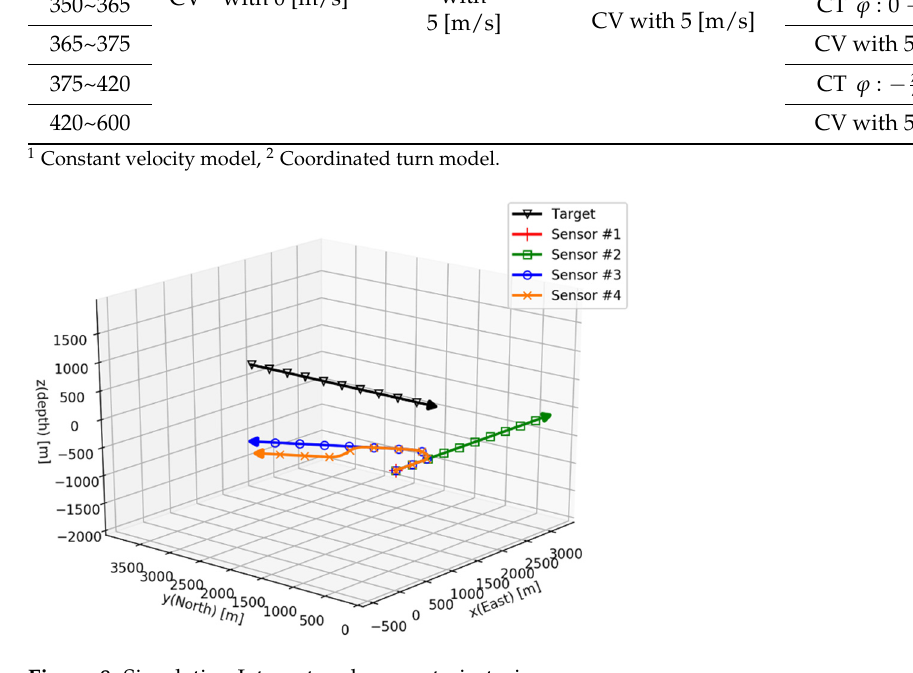
Figure 8. Simulation I: target and sensor trajectories.